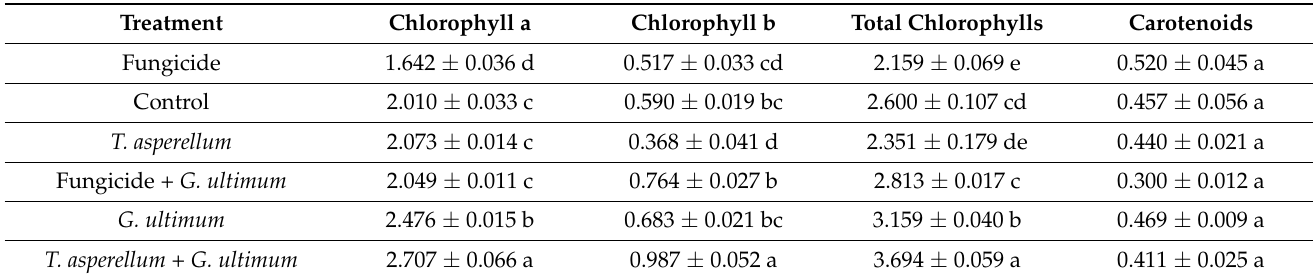
Table 5. Chlorophylls and carotenoids content (mg g − 1 fresh weight) of pea plants under inoculation with T. asperellum ZNW and/or G. ultimum